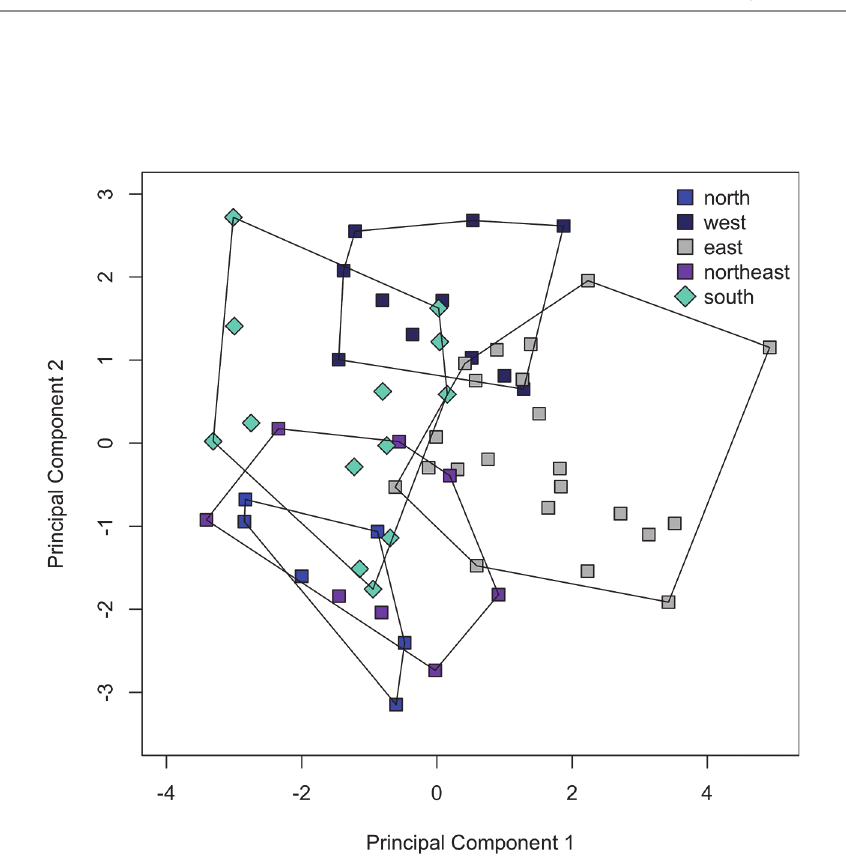
Fig 5. PCA on meristics of S . babaulti and S . pleurospilus . PC2 vs. PC1 of a PCA on the 15 meristics for 60 specimens belonging to four geographical groups of S . babaulti and to S . pleurospilus (the southern